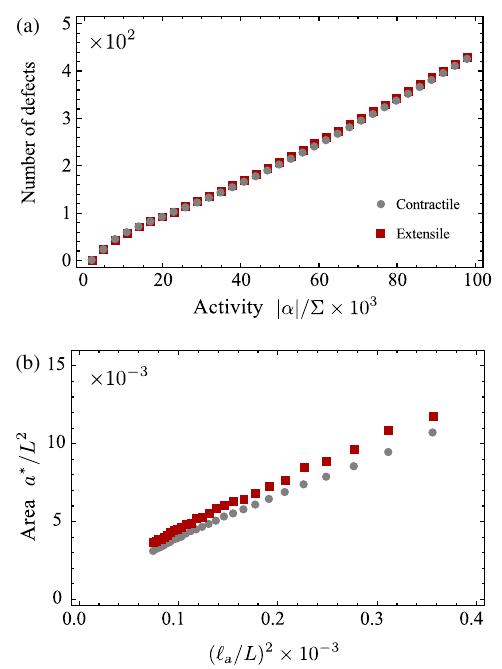
ffiffiffiffiffiffiffiffiffiffiffiffi p K= j α j for contractile a ¼